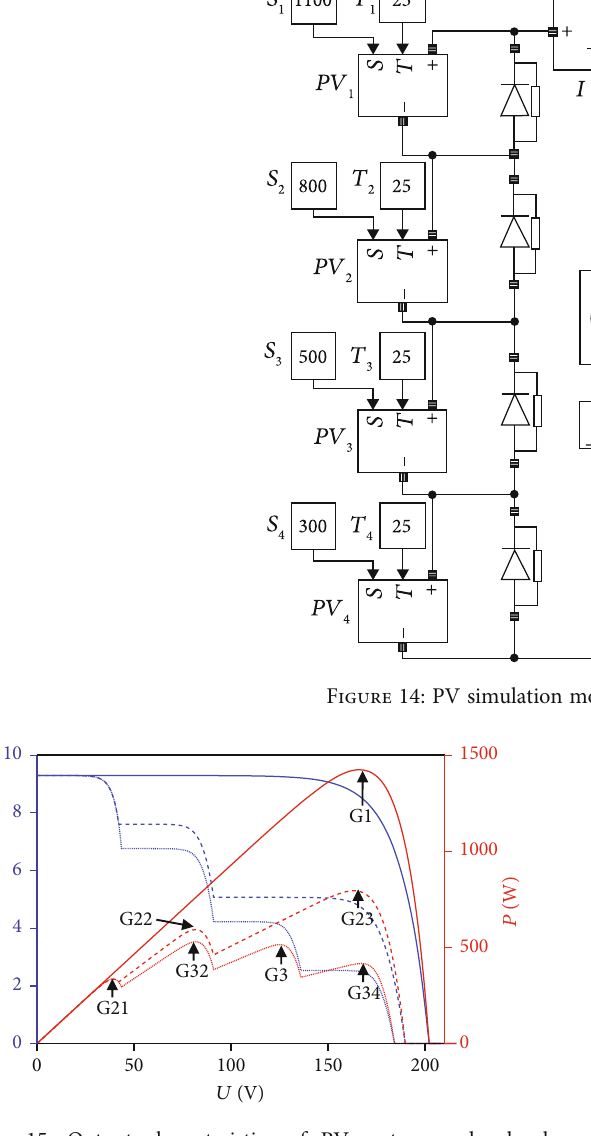
Figure 15: Output characteristics of PV system under local